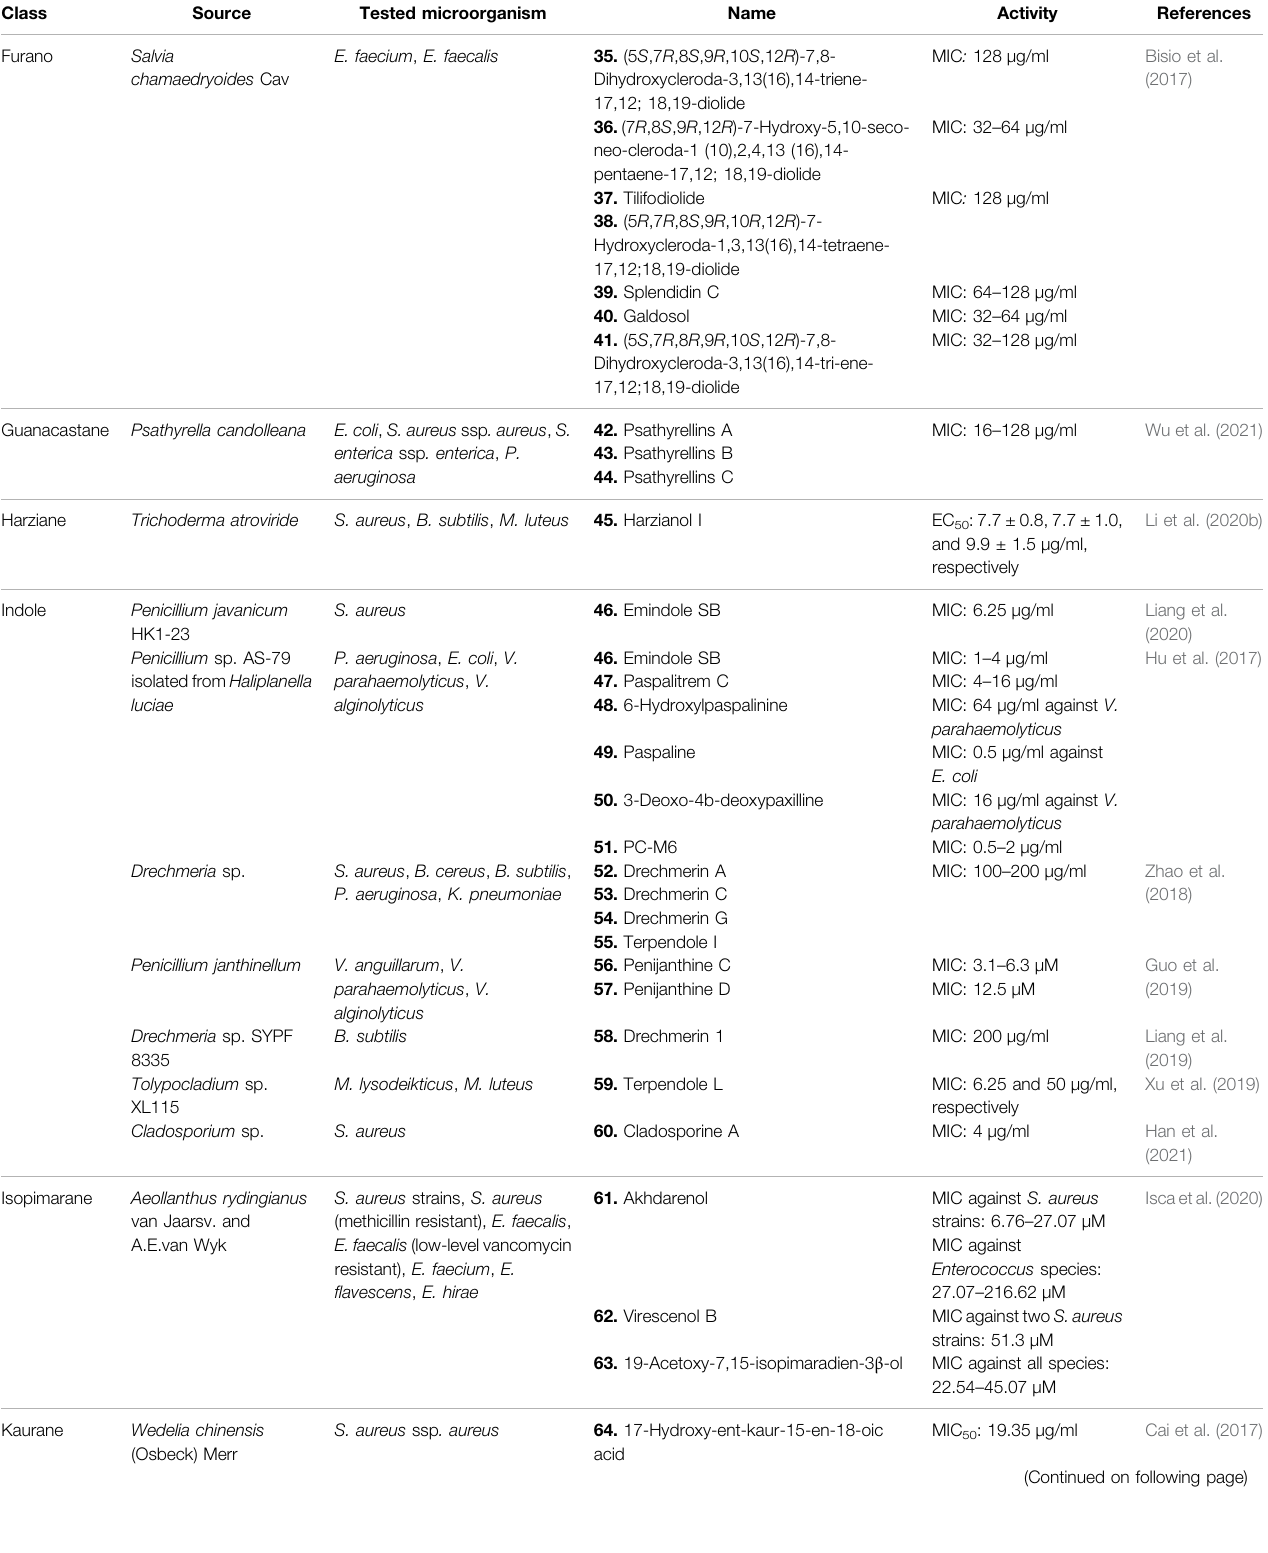
TABLE 1 | ( Continued ) Different classes of diterpenoids isolated from natural sources with signi fi cant antibacterial